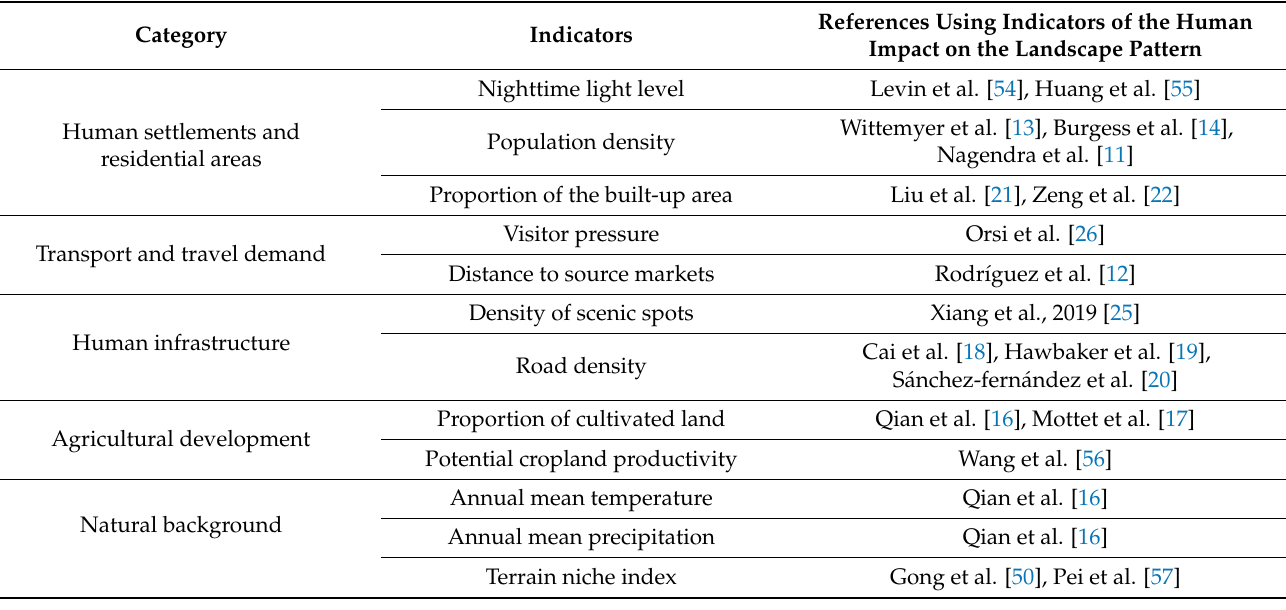
Table 1. The indicators of the impact of human activities on the landscape